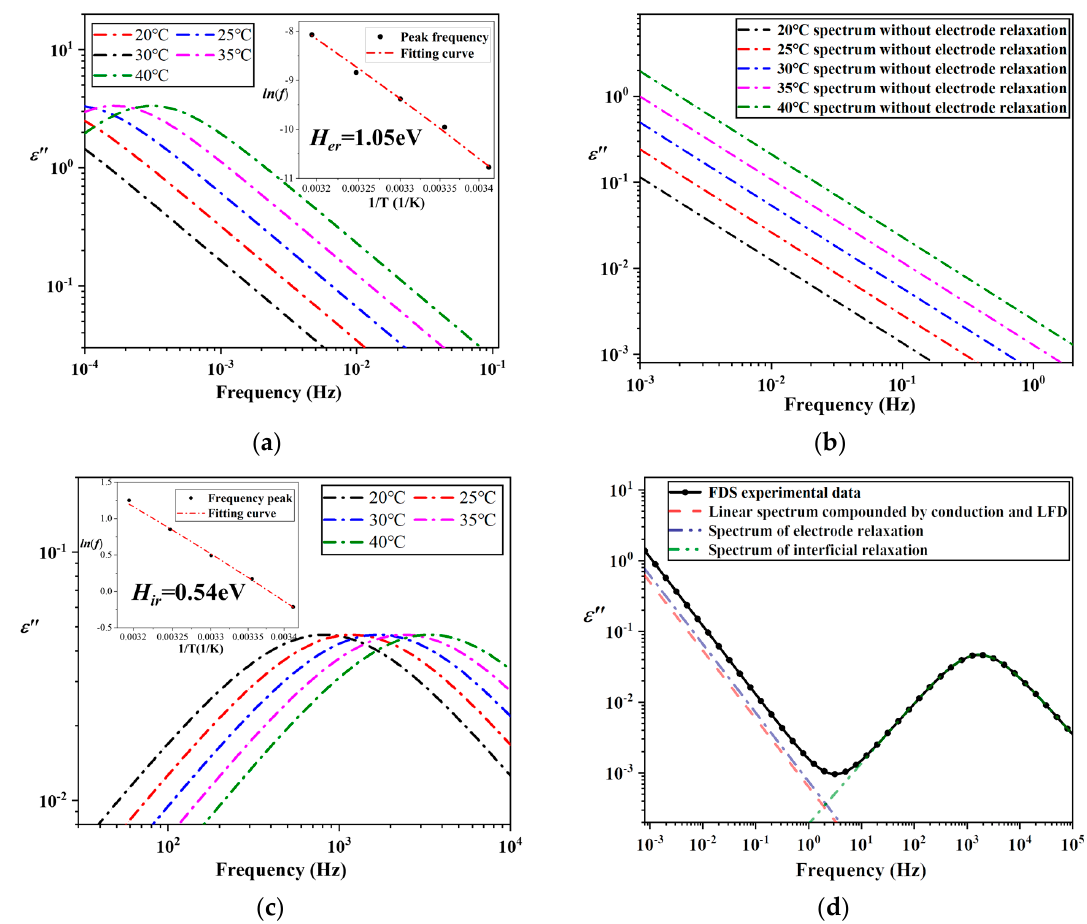
Figure 12. Data analysis for FDS tested in the middle-temperature range. ( a ) Independent spectra for electrode relaxation in the middle-temperature range. ( b ) Compound spectra for linear conduction and LFD processes in the middle-temperature range. ( c ) Independent spectra for interfacial relaxation in the middle-temperature range. ( d ) Physical model of FDS tested in the middle-temperature range.